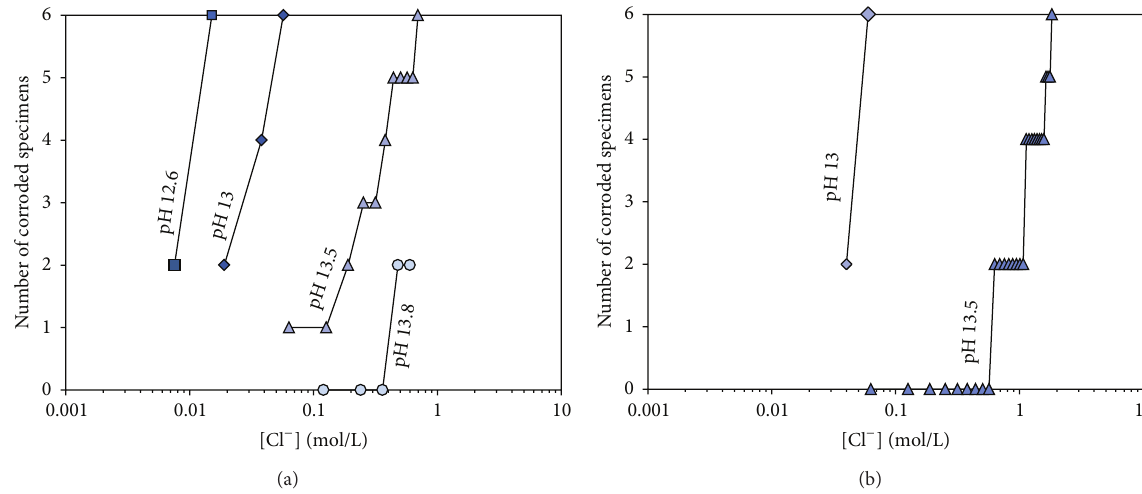
Figure 1: Number of corroded specimens as a function of chloride addition during potentiostatic test in lime solutions without inhibitor; (a) 70 h and (b) 90 h of passivation.